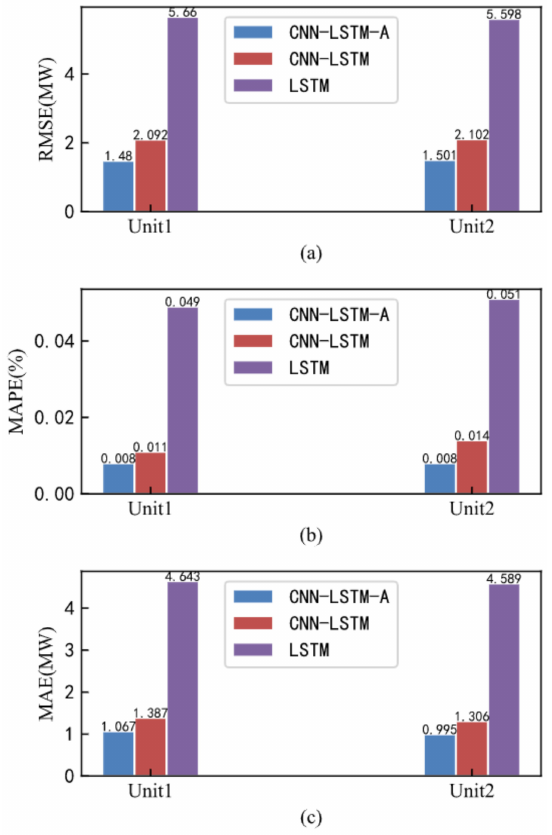
Figure 10. Prediction error: ( a ) RMSE; ( b ) MAPE; ( c ) MAE. The CNN-LSTM-A load prediction model proposed in this paper has a minimum RMSE and a MAPE of less than 1.1% when predicting the power of the two turbines, which has a very high